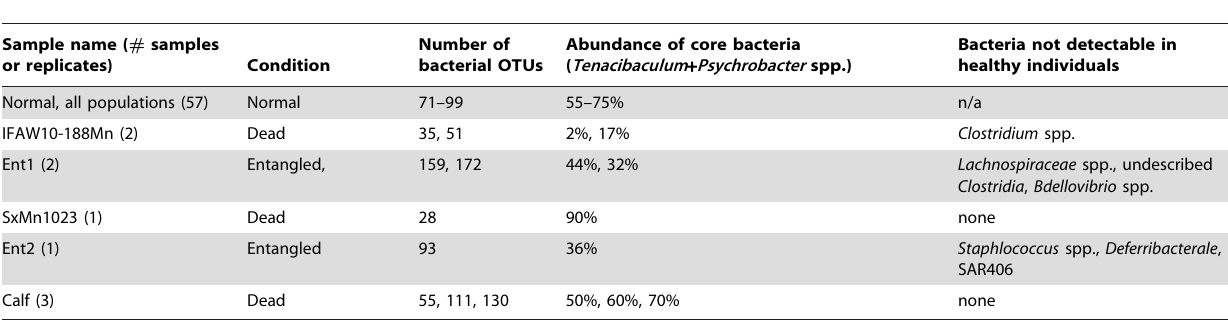
Table 6. Comparison of skin-bacteria among normal, health-compromised and dead humpback whales, (n/a) indicates not applicable.